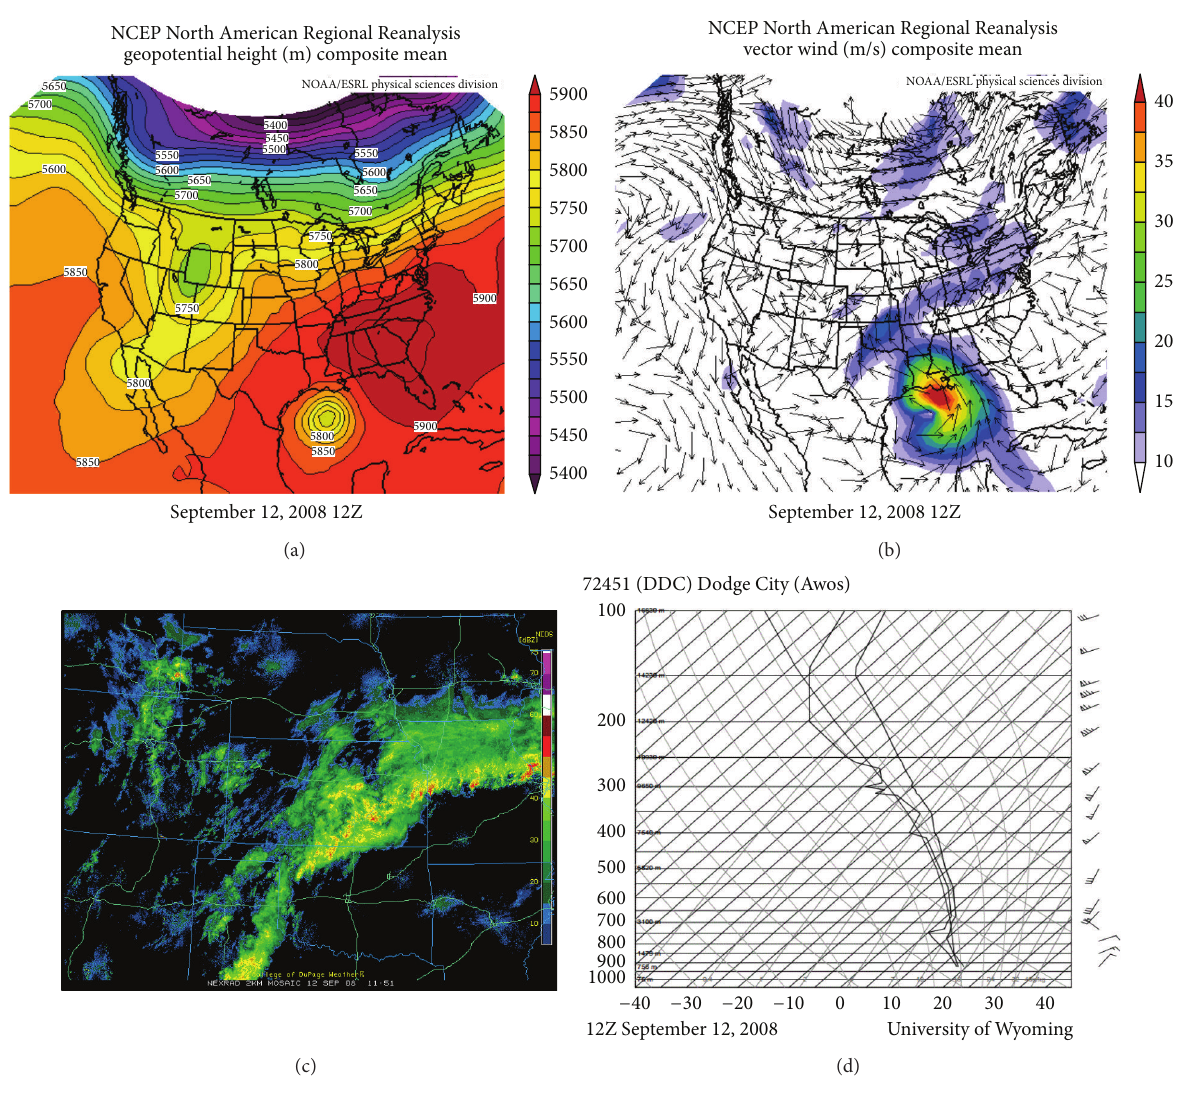
Figure 4: The ideal case for Wichita, KS. (a) 500 mb, (b) 850 mb, (c) radar still, and (d) sounding for Dodge City.